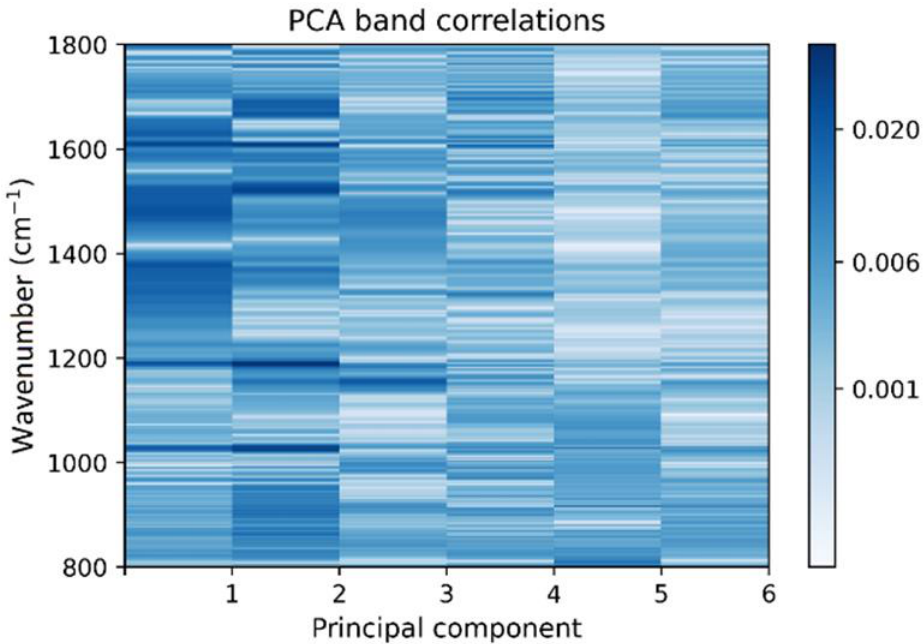
Figure 3. Correlation matrix for principal components (PCs) and the contribution (loading) of each wavenumber of the Raman spectra to the PC.